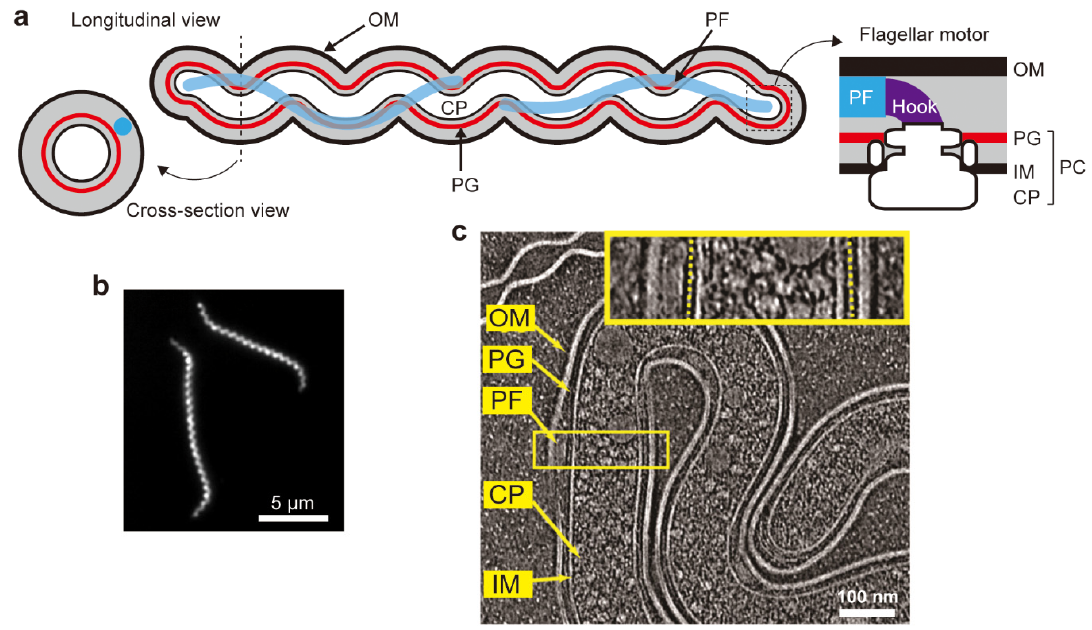
Figure 1. Spirochetal cell structure. ( a ) Schematics of longitudinal and zoom-in cross-section views of the cell structure and the flagellar motor shared by spirochete species; outer membrane (OM), periplasmic flagellum (PF), peptidoglycan layer (PG), inner membrane (IM), cytoplasm (CP), and protoplasmic cylinder (PC) are shown. If readers view from the hook to the motor, the flagellar motor rotates in a counterclockwise (CCW) direction at one pole of a single cell, whereas the motor at another cell pole rotates in a clockwise (CW) direction. ( b ) Dark-field micrograph of Leptospira biflexa . ( c ) Longitudinal slice image obtained by cryo-electron tomography of L. biflexa (adapted from [14] with permission from the publisher). OM, IM, and PF are clearly visible, and PGs observed in the yellow square are indicated by yellow dashed lines in the enlarged view (inset).